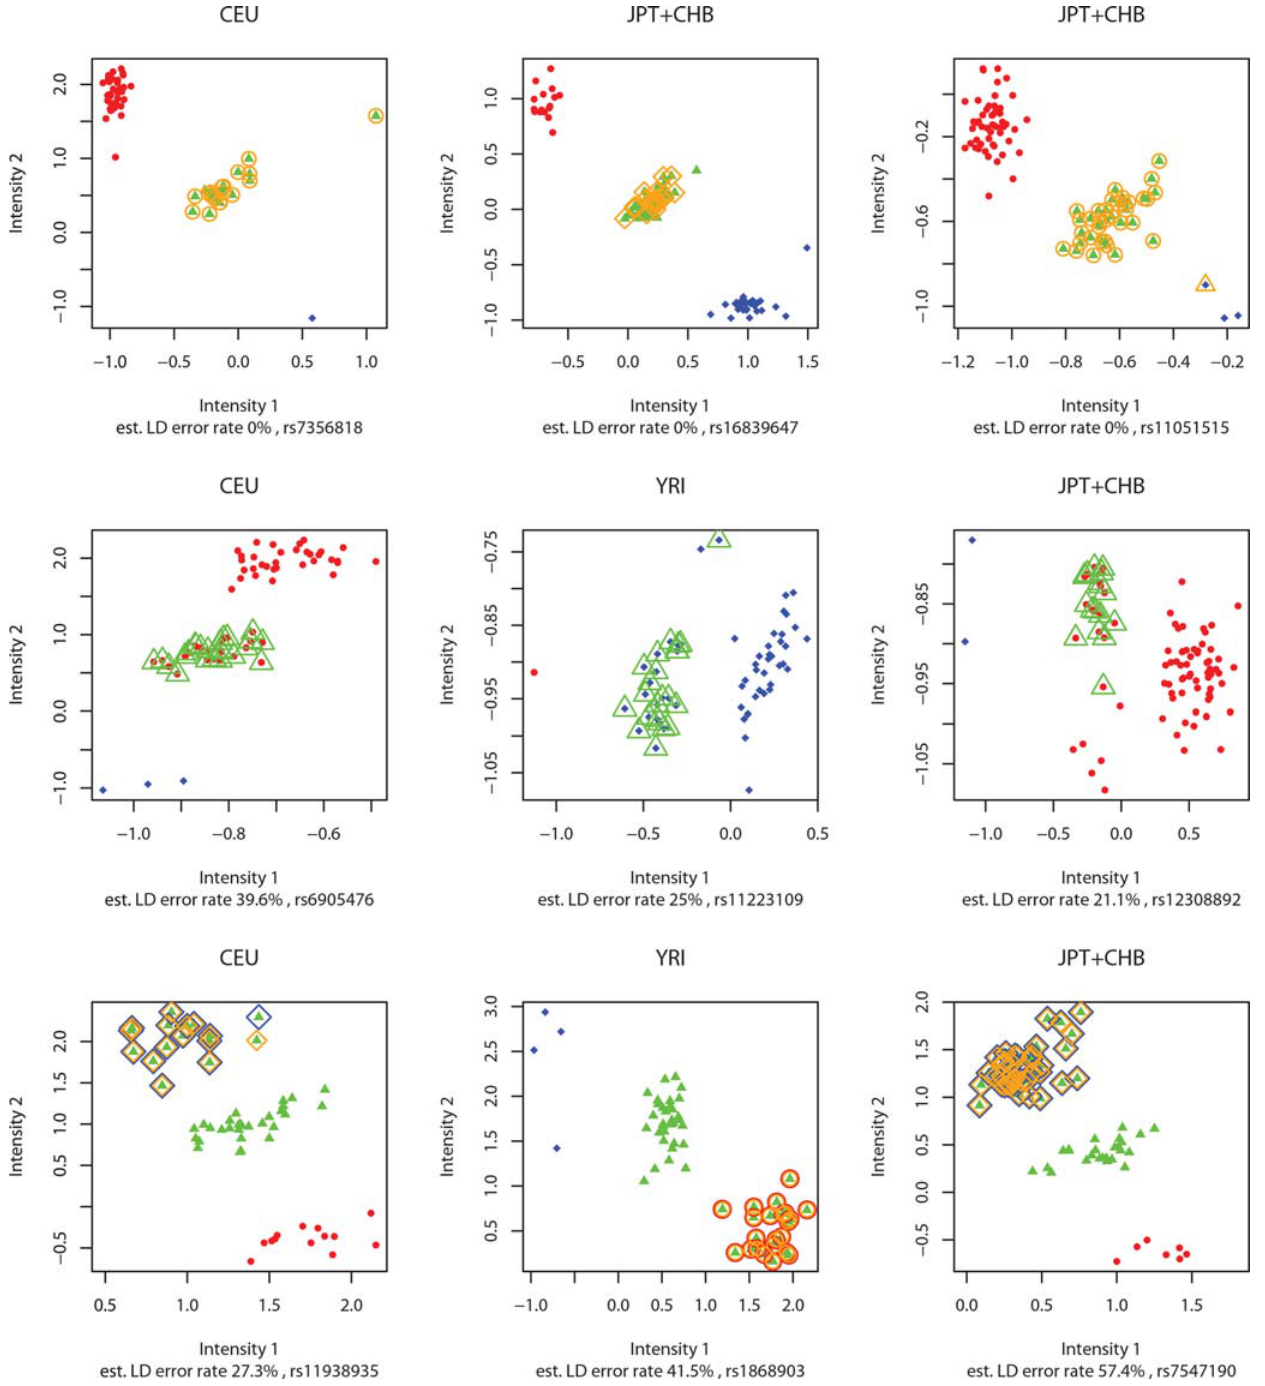
Figure 2. Example genotype intensity scatter plots from Affymetrix 500K technology on unrelated HapMap samples. Original calls from the Affymetrix data are indicated by colour and shape of the small solid points (homozygotes: blue ¤ , red N , heterozygotes: green m ). The larger, open symbols with the same colour scheme ( e , # , D ) represent corrected genotype calls from applying our LD-based method to the Affymetrix data. Orange symbols indicate genotypes that are discrepant between the Affymetrix and HapMap datasets, with the shape of these symbols indicating the genotype calls in the HapMap database. LD-based error rate estimates are those obtained from applying the LD-based method to the Affymetrix data. The first row shows plots for three SNPs with large numbers of discrepancies between HapMap and Affymetrix calls, but low LD- based error rate estimates and clean intensity plots, with three well-separated clusters. The likely explanation for these results is that the discrepancies are due to errors in the HapMap database, and not the Affymetrix calls on which the LD-based error rates are based. The second row shows plots for three SNPs where the HapMap and Affymetrix calls agree (0 discrepancies) but high LD-based error rate estimates and unusual intensity plots. The unusual intensity results, combined with the fact that genotypes identified as likely to be incorrect by the LD-based method tend to cluster together, suggests that the high LD-based error rates reflect genuine signal at these SNPs, such as genotyping errors or other anomalies (e.g. copy number variation). This illustrates the potential for the LD-based method to detect problems that duplicate genotyping may miss. The third